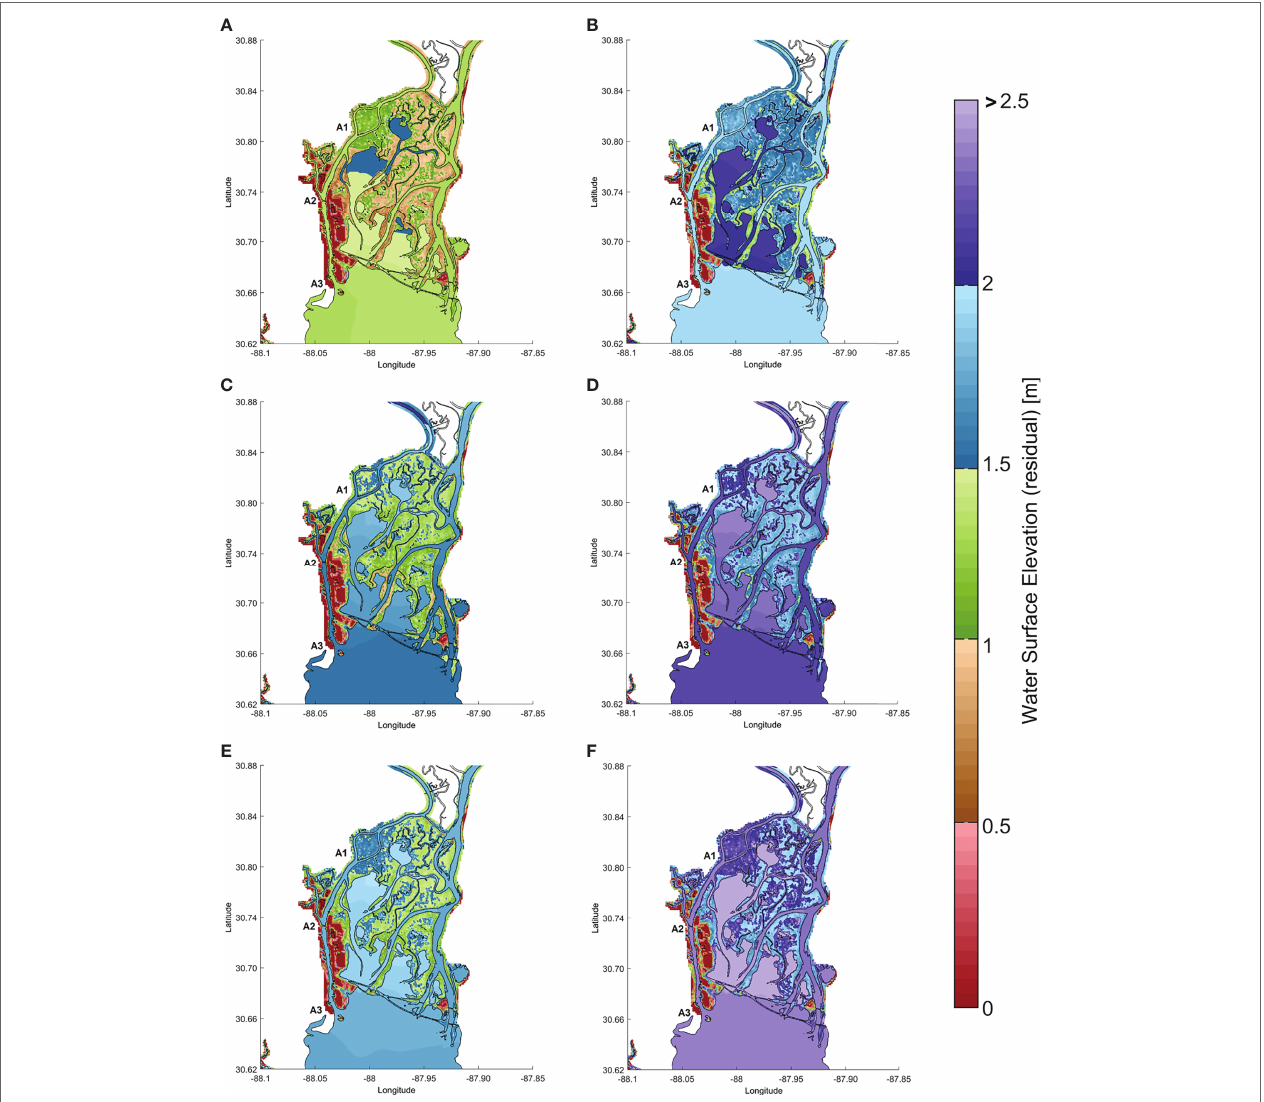
FIGURE 7 | Residuals of maximum water surface elevation (WSE) between the baseline scenario (M-M) and those with sea level rise (SLR) projections: RCP 4.5 (left panel) and 8.5 (right panel). Residuals are computed for (A, B) M-M + SLR, (C, D) H-H + SLR, and (E, F) CF +SLR scenarios. Black polygon delineates the current tidal channel morphology. A1 to A3 are control stations located in the Mobile River